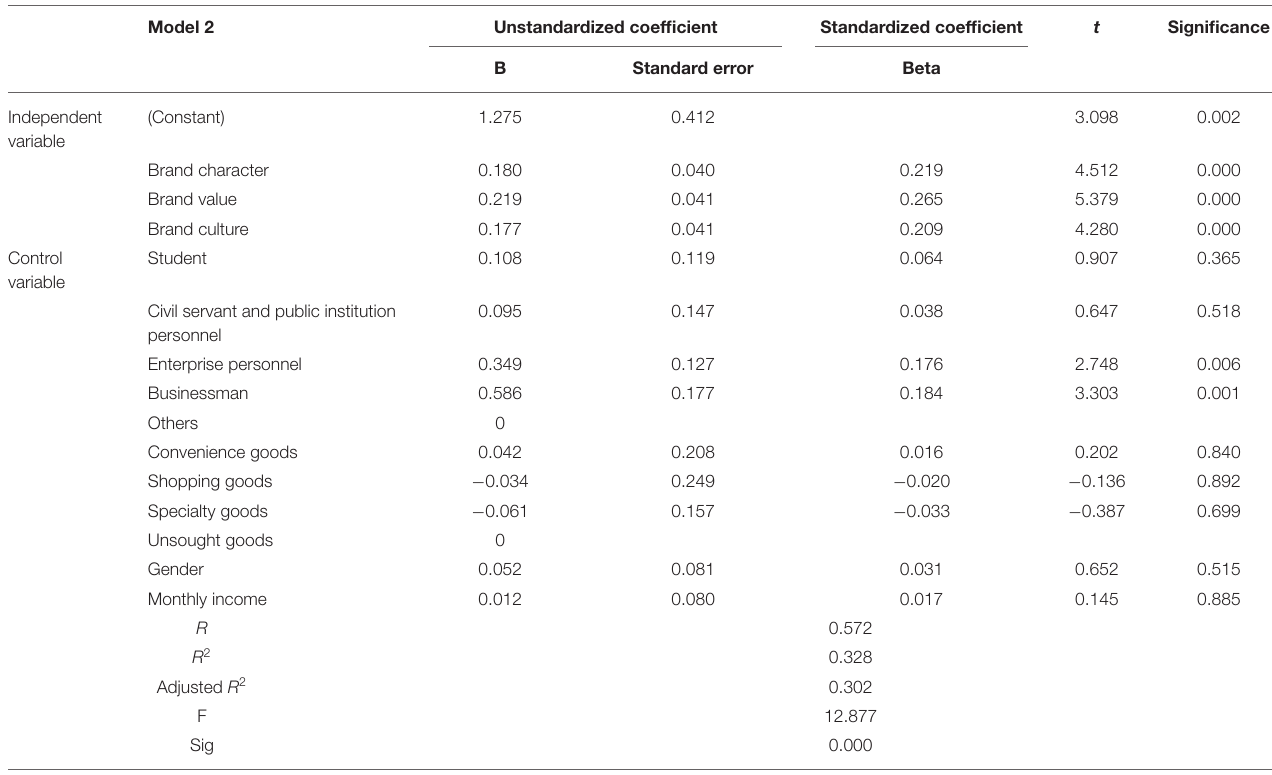
TABLE 3 | Regression analysis of the dimensions of brand elements to consumers’ purchase